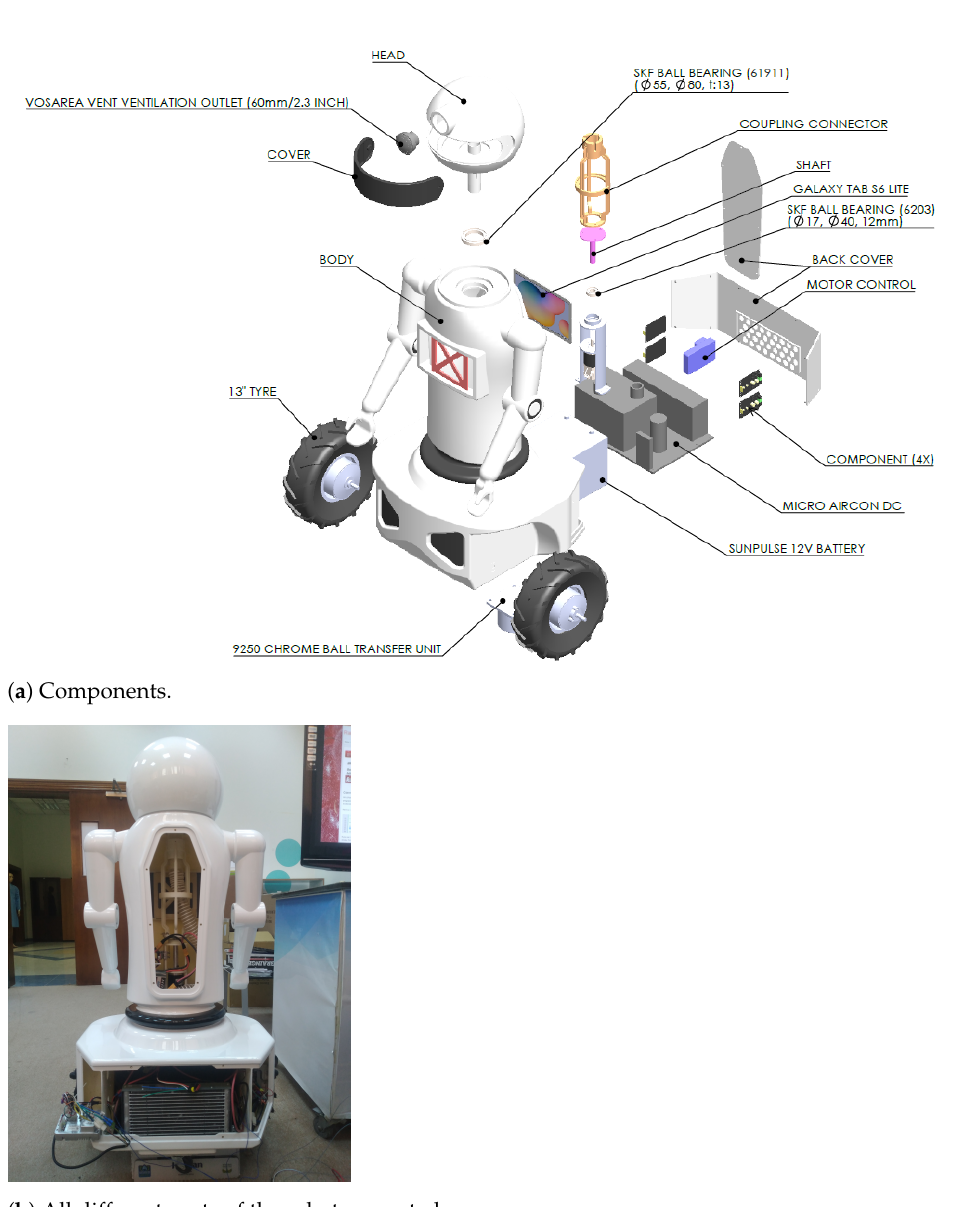
Figure 27. Mechanical